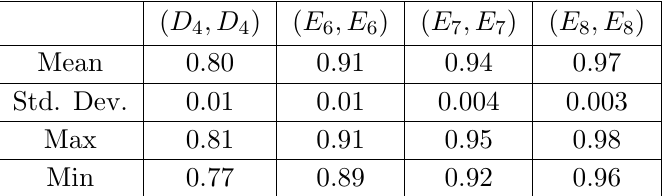
Table 6. Table of means and standard deviations for the ratio a IR =c IR across the entire nilpotent network de(cid:12)ned by plain mass deformations of 4D conformal matter. We also display the maximum and minimum values.